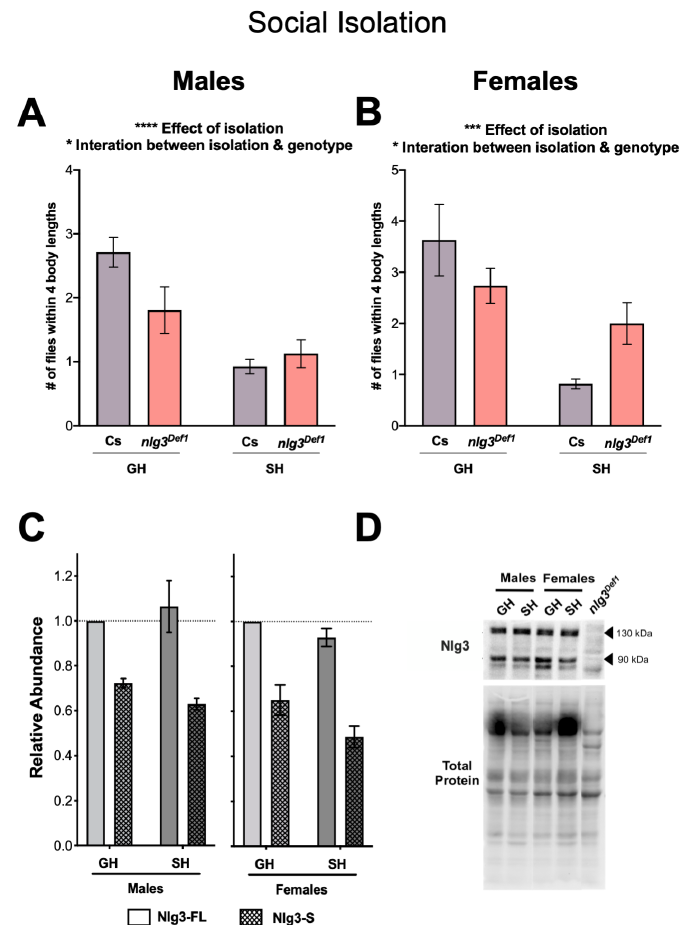
Figure 5. Social isolation: reduced response in social space in nlg3 Def1 flies, but no effect on protein levels in Canton-S. ( A – D ) Mean number of flies within 4BL ± s.e.m. in Cs, nlg3 Def1 and nlg3 L04 . n = 9 trials with 12–17 flies per trial. ( A ) Single housed Cs and nlg3 Def1 had a lower number of flies within 4BL after being single housed compared to group housed (two-way ANOVA—effect of isolation: F 1,32 = 24.56, p < 0.0001); however SH nlg3 Def1 did not have as drastic a decrease compared to Cs (two-way ANOVA—interaction between isolation and genotype: F 1,32 = 4.96, p = 0.0331). ( B ) Similar results as the males were obtained with nlg3 Def1 females (two-way ANOVA—effect of isolation: F 1,28 = 15.10, p = 0.0006; two-way ANOVA—interaction between isolation and genotype: F 1,28 = 5.166, p = 0.0309). ( C ) Nlg3 protein abundance in Cs males did not change in SH compared to GH flies in either protein isoform. The same Nlg3 expression pattern was observed in females. ( D ) Representative Western blots for Cs male and female GH or SH. Male treatments are relative to GH Nlg3-FL; males and female treatments are relative to GH Nlg3-FL females. GH: group housed, SH: single housed. All samples are normalized to total protein. n = 4 for all Western.